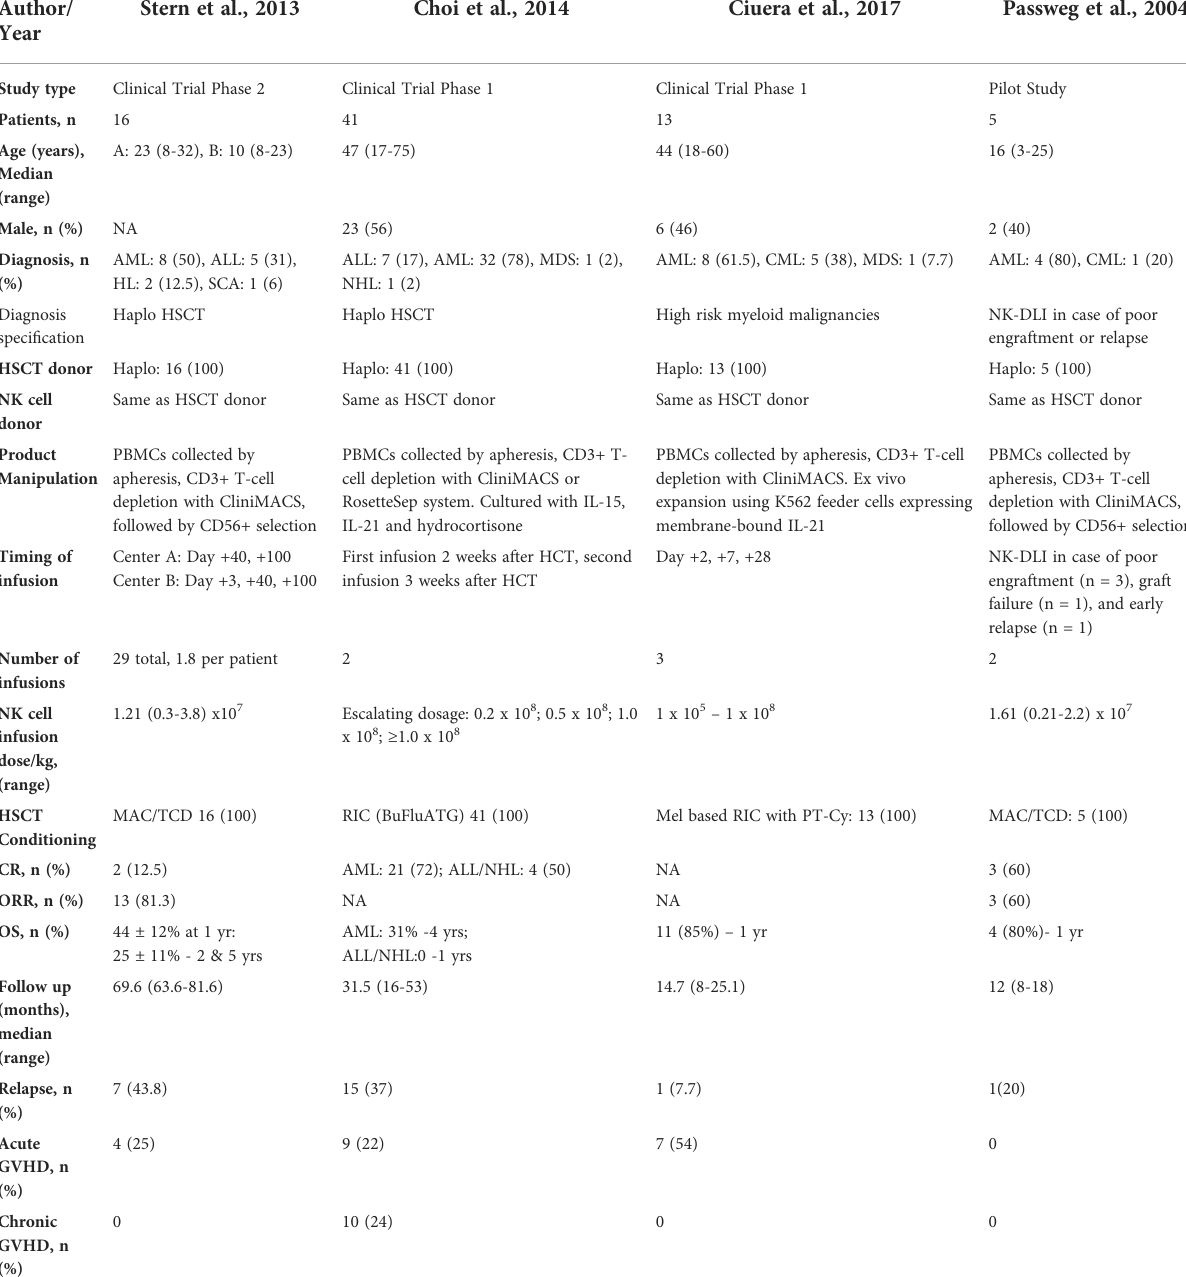
TABLE 4 Impact of pre-emptive/prophylactic NK cells infusions on outcomes after haploidentical